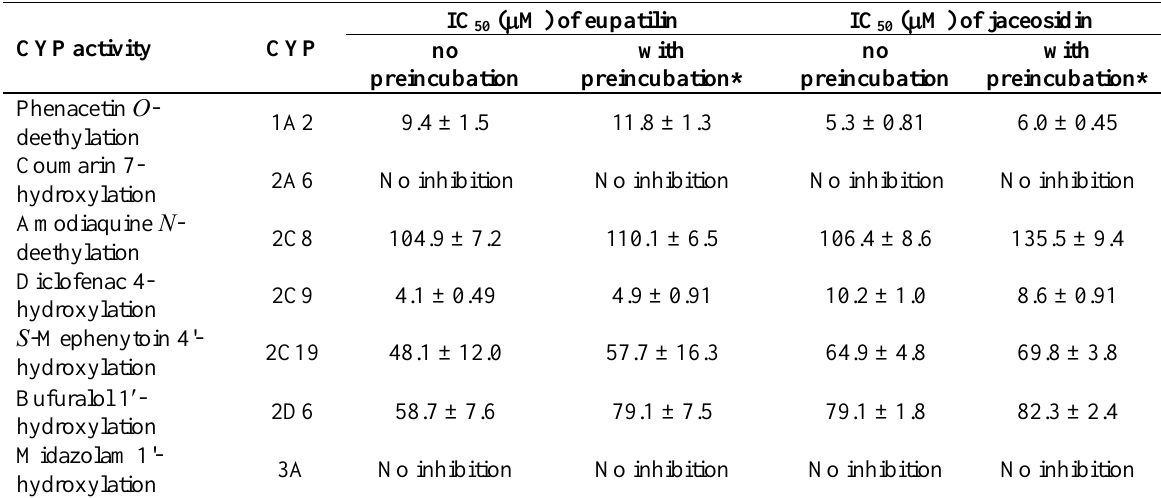
Table 1. Effects of eupatilin and jaceosidin on CYP metabolic activity in pooled human liver microsomes with IC values. 50